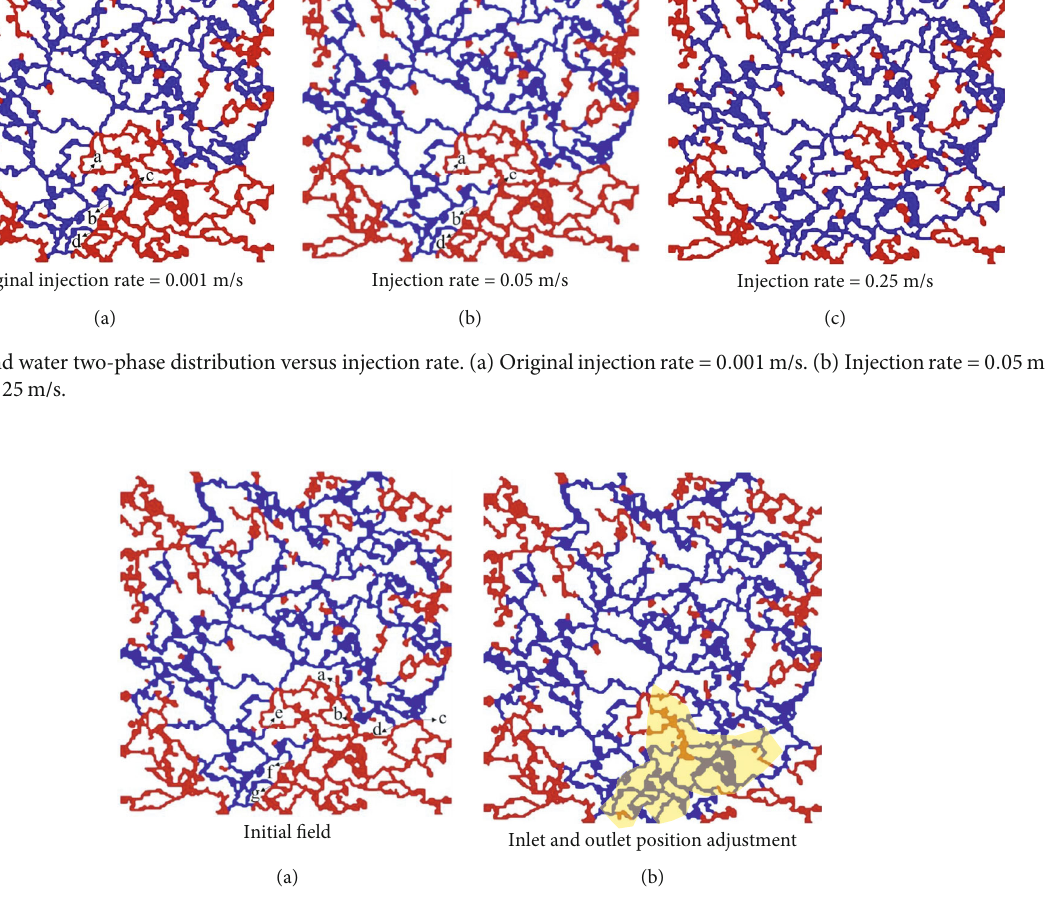
Figure 13: Oil and water two-phase distribution at new inlet and outlet. (a) Initial fi eld. (b) Inlet and outlet position